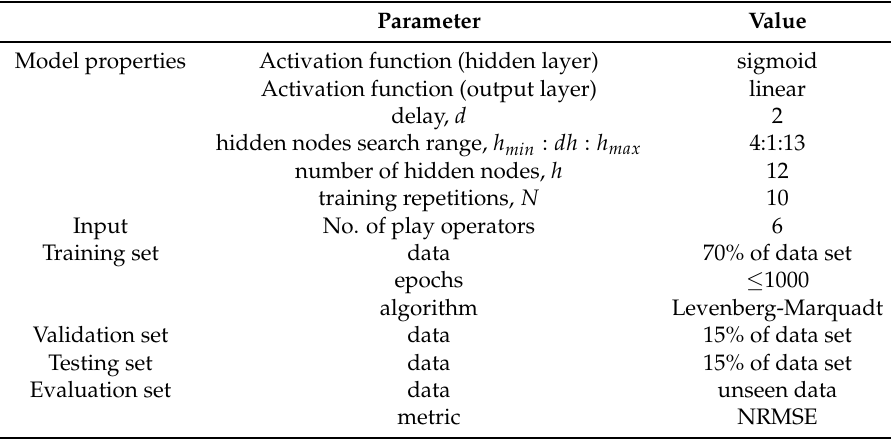
Figure 7. Flowchart showing the model training and validation procedure. Table 1. RNN parameters